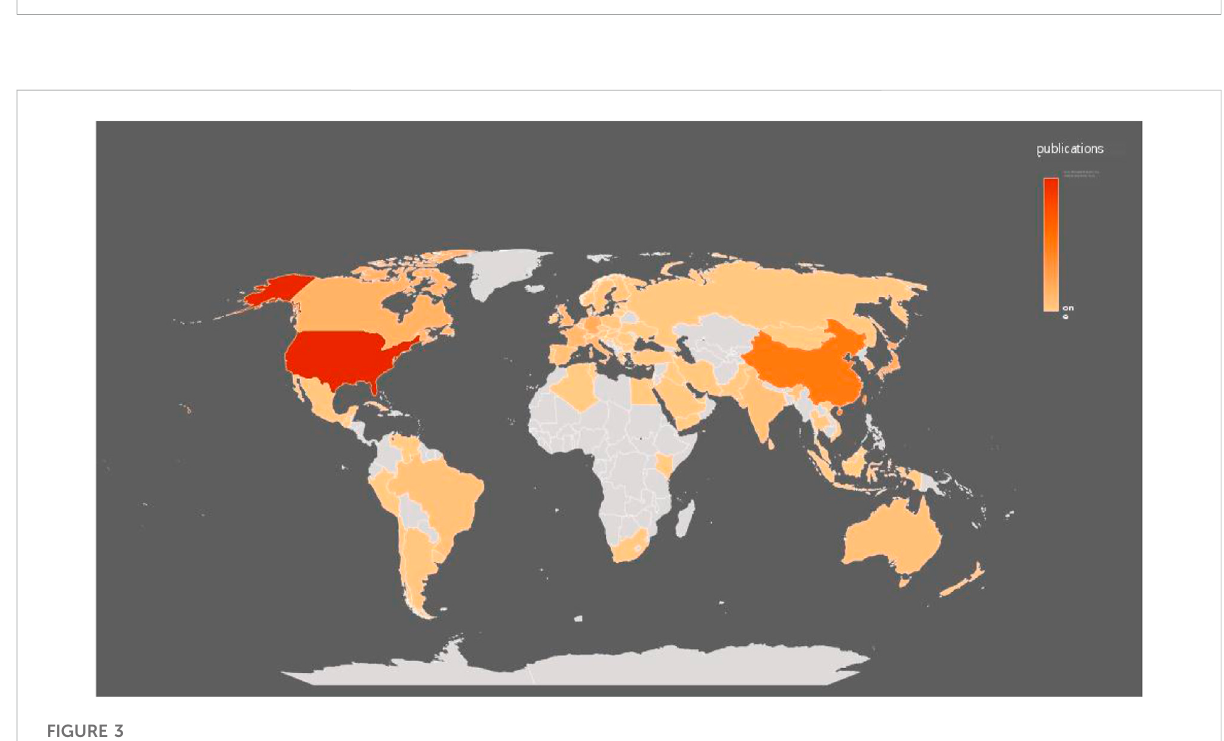
FIGURE 3 Spatial distribution of global